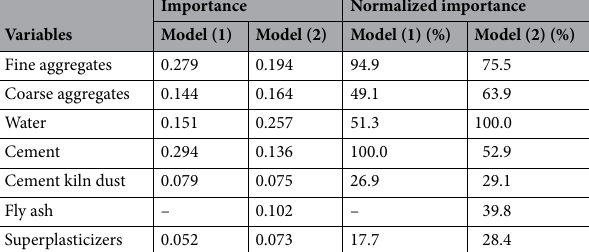
Table 6. Variable importance.